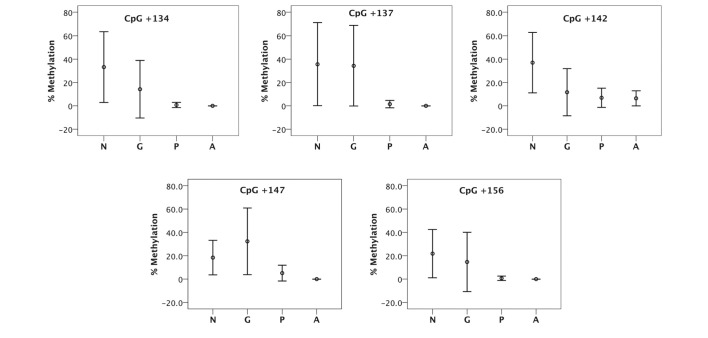
Statistical analysis of individual CpG site methylation degree. The plots represent the mean ± standard deviation of the percentage of methylation at each CpG site in each tissue. Statistical analysis was performed to verify whether the percentage of methylation was statistically significantly higher in normal thyroid and goiter compared with papillary and anaplastic thyroid carcinoma. Under the assumption of unequal variance on the variable among the groups (Levene’s test for equality of variance; P<0.003), statistically significant results were observed (Student’s t test, P= 0.02–0.06). N, normal thyroid; G, goiter; P, papillary; A, anaplastic thyroid carcinoma; Gal-3, galectin-3.